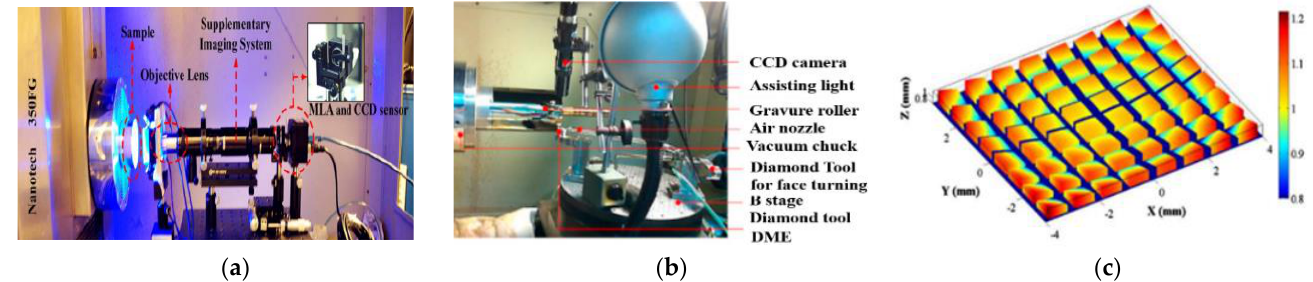
Figure 3. In situ DPA 3D measurement system. ( a ) Reprinted with permission from ref. [42] © 2015 The Optical Society; ( b ) Experimental equipment of dimethyl ether for gravure roller [43]; ( c ) Free-form micro-lens array. Reprinted with permission from [44] © 2015 The Optical Society.